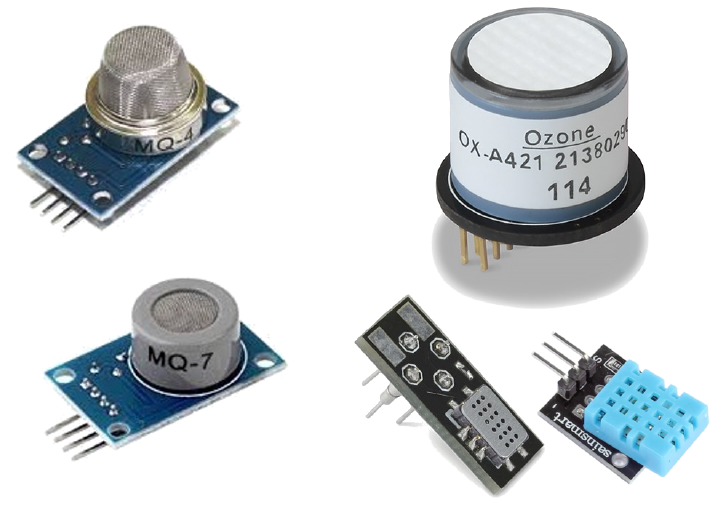
Figure 18. Different types of air pollution